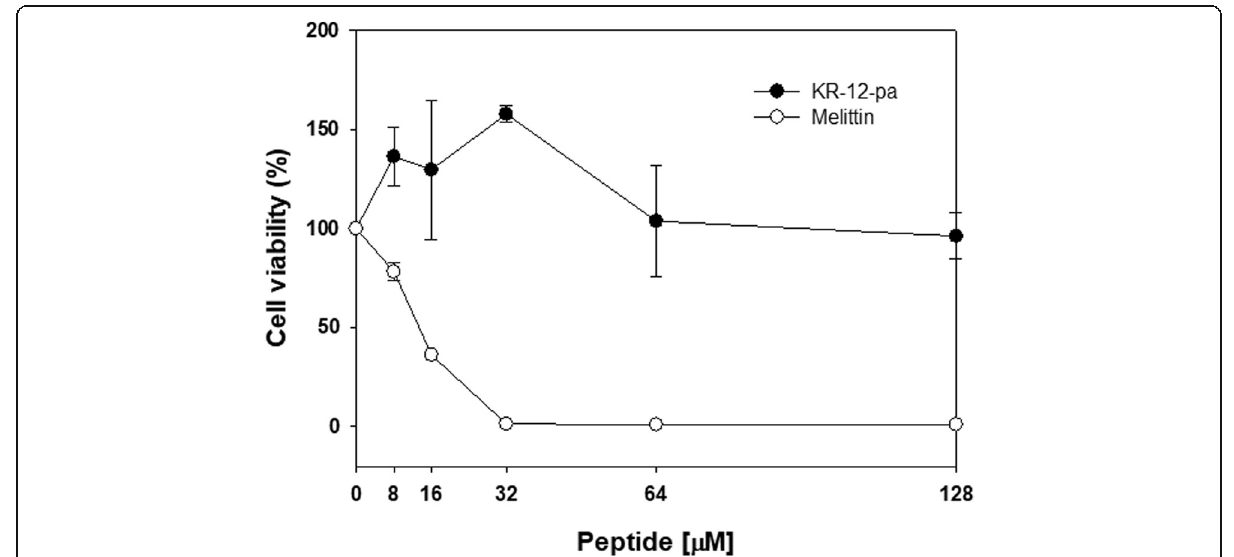
Fig. 6 Cytotoxicity by MTT assay against mouse macrophage RAW 264.7 cells induced by KR-12-pa or melittin peptides (0-512 μ